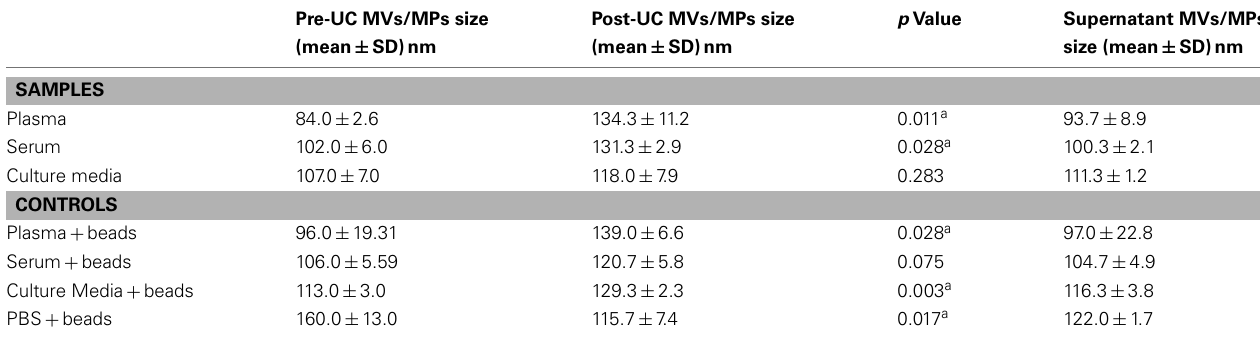
Table 2 | Evaluation of microvesicles/microparticles size pre-UC and